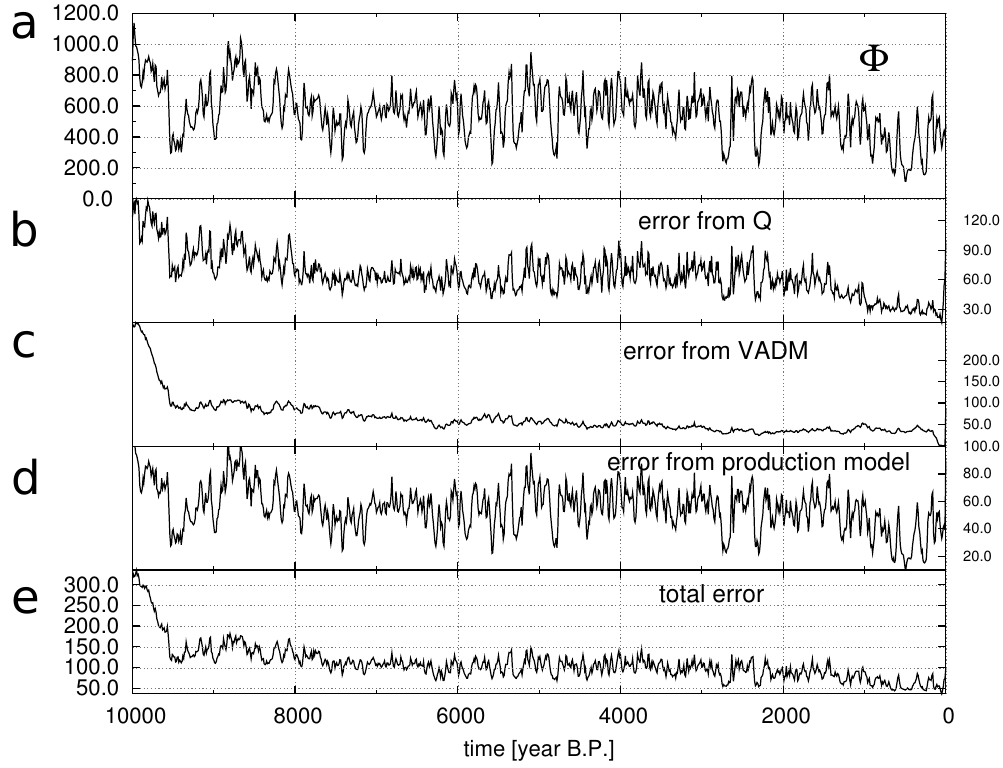
Fig. A2. Assessment of uncertainties in the solar modulation potential 8 in MeV. (a) Best estimate of 8 (mean of the Monte Carlo simu- lations), (b) uncertainty in 8 from uncertainties in the radiocarbon production Q , (c) from the uncertainty in the VADM reconstruction by Korte et al. (2011), (d) the uncertainty in the model to convert production into 8 , and (e) total 1 σ uncertainty in the MC